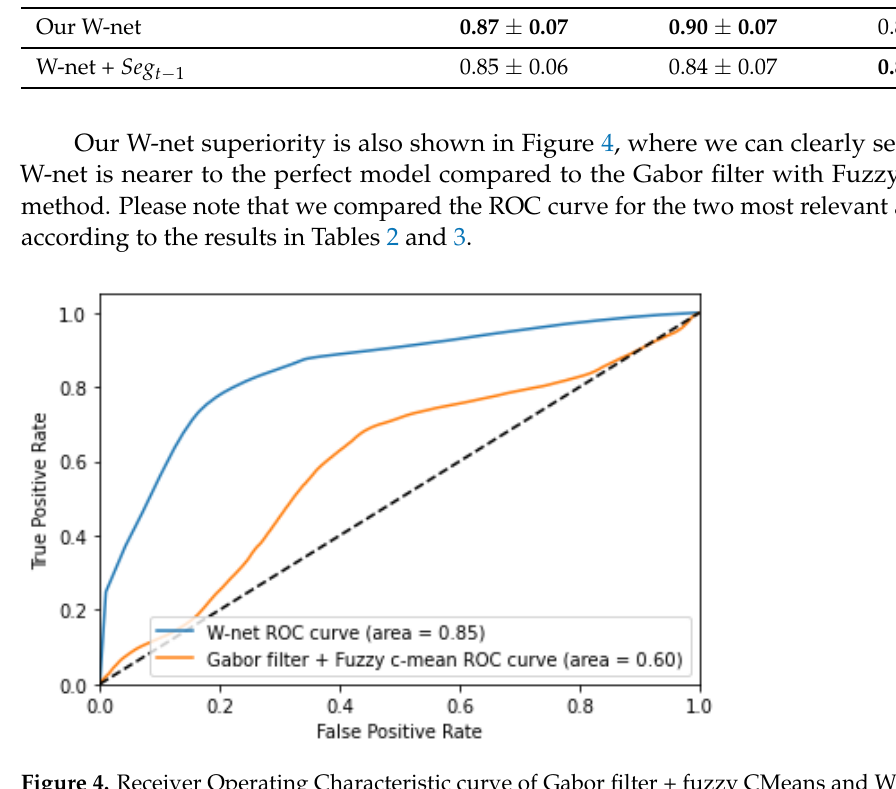
Figure 4. Receiver Operating Characteristic curve of Gabor filter + fuzzy CMeans and W-net.